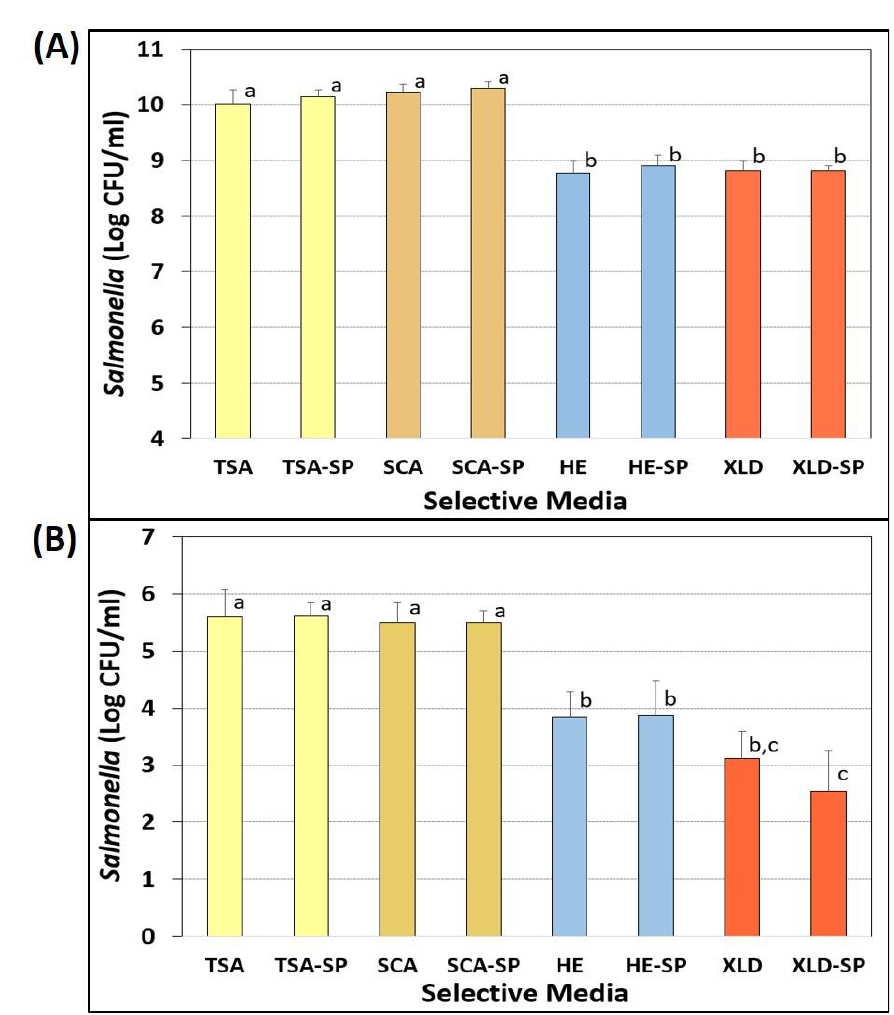
Figure 5. Evaluation of sodium pyruvate for recovery of injured Salmonella ( A ) after 10-day nutrient starvation or ( B ) after 30-min salt and vinegar (acid) marinade treatment on inoculated beef pieces. Enumeration of mixed- Salmonella serovars on TSA, SCA, Hektoen Enteric (HE), Xylose Lysine Desoxycholate (XLD), and on the same media containing 0.1% sodium pyruvate (TSA-SP, SCA-SP,